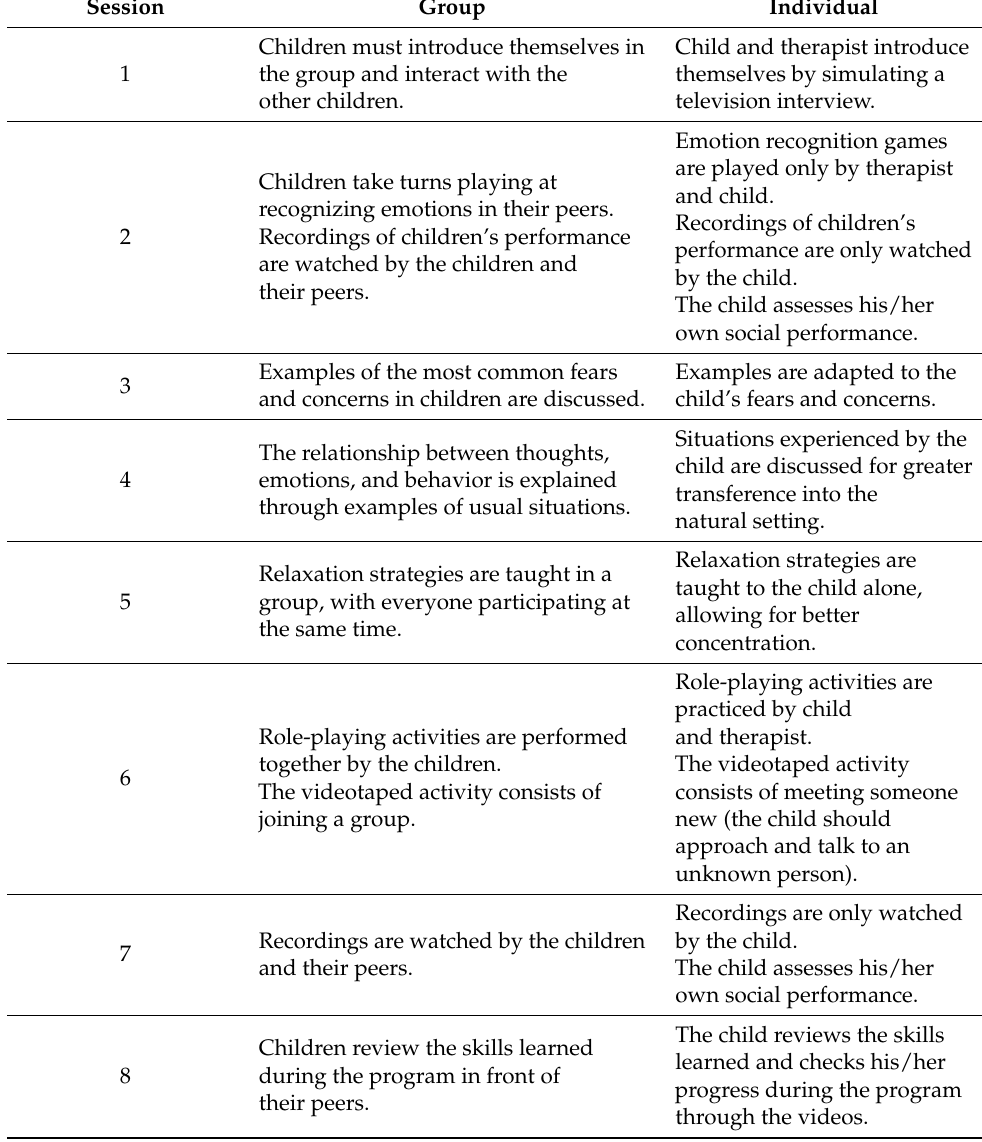
Table 2. Differences between the Super Skills for Life (SSL) program